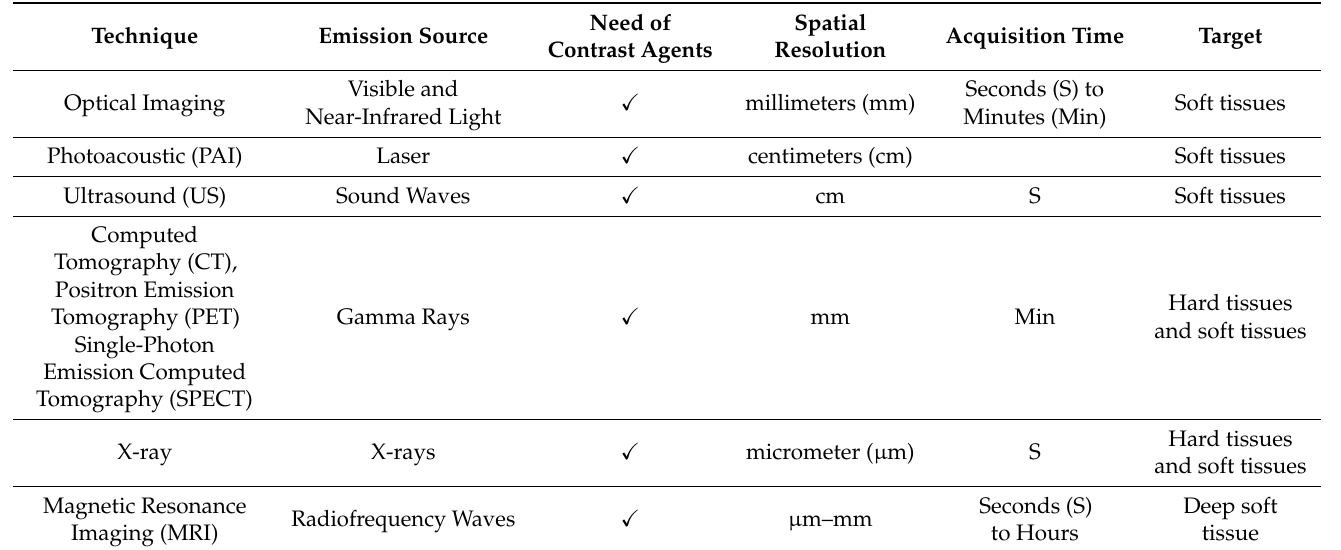
Table 1. Features of in vivo imaging modalities including their emission source, technique’s re- quirement of a contrast agent, their penetration depth, acquisition time and the targeted region for